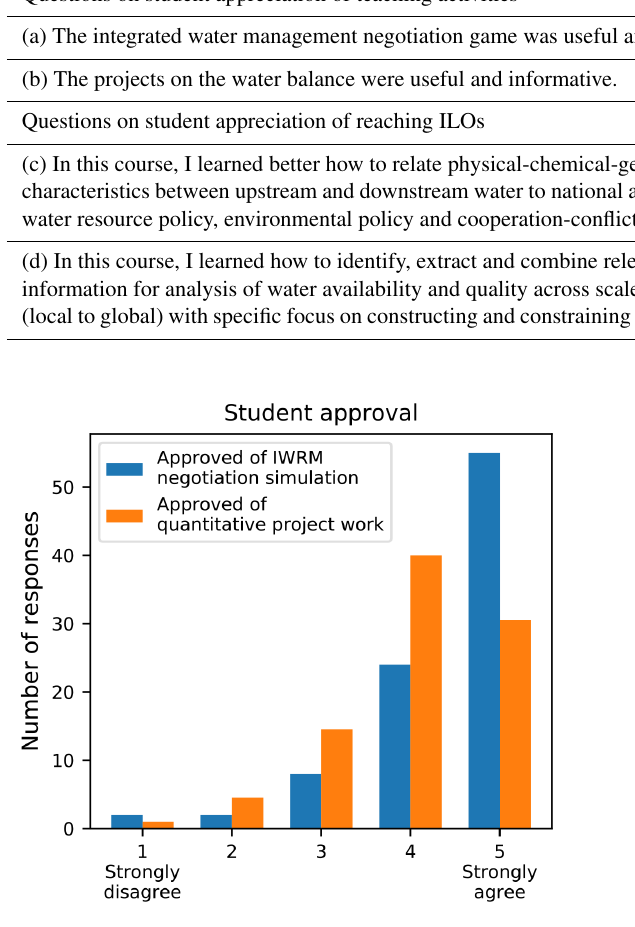
Figure 1. Student approval ratings. Distribution of pooled responses to student surveys over